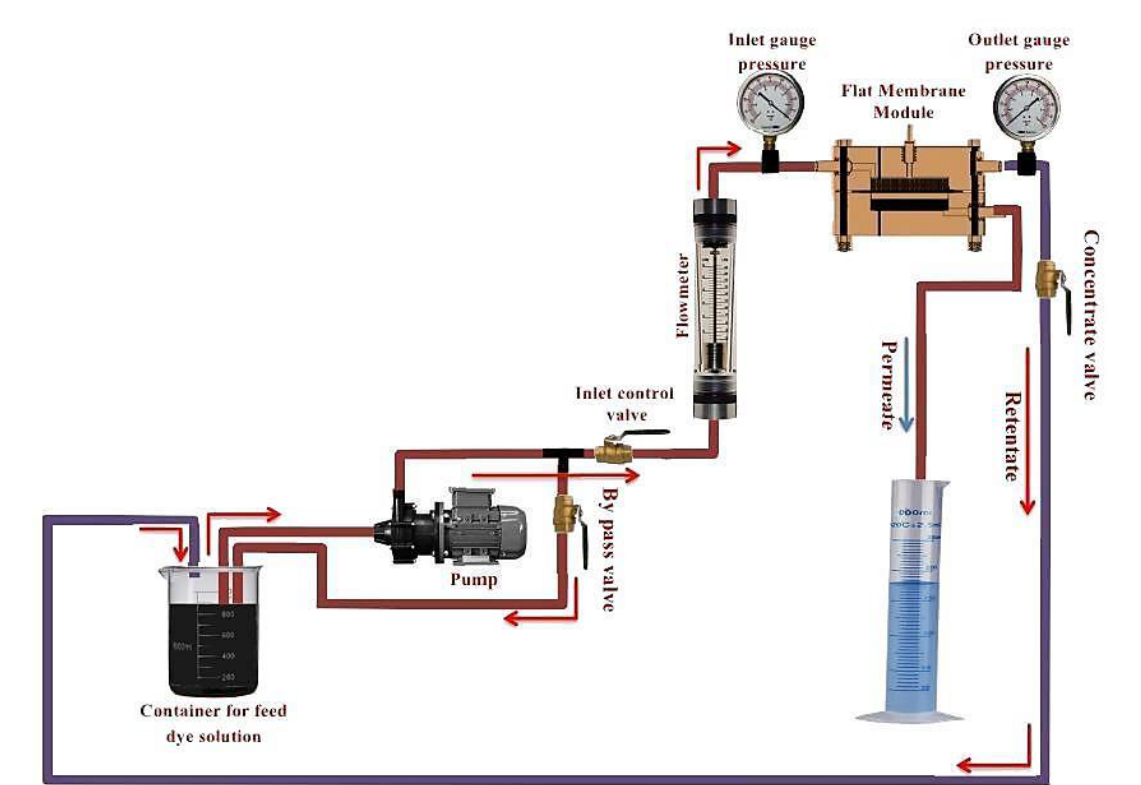
Scheme 1. Schematic diagram of the cross-flow filtration system.